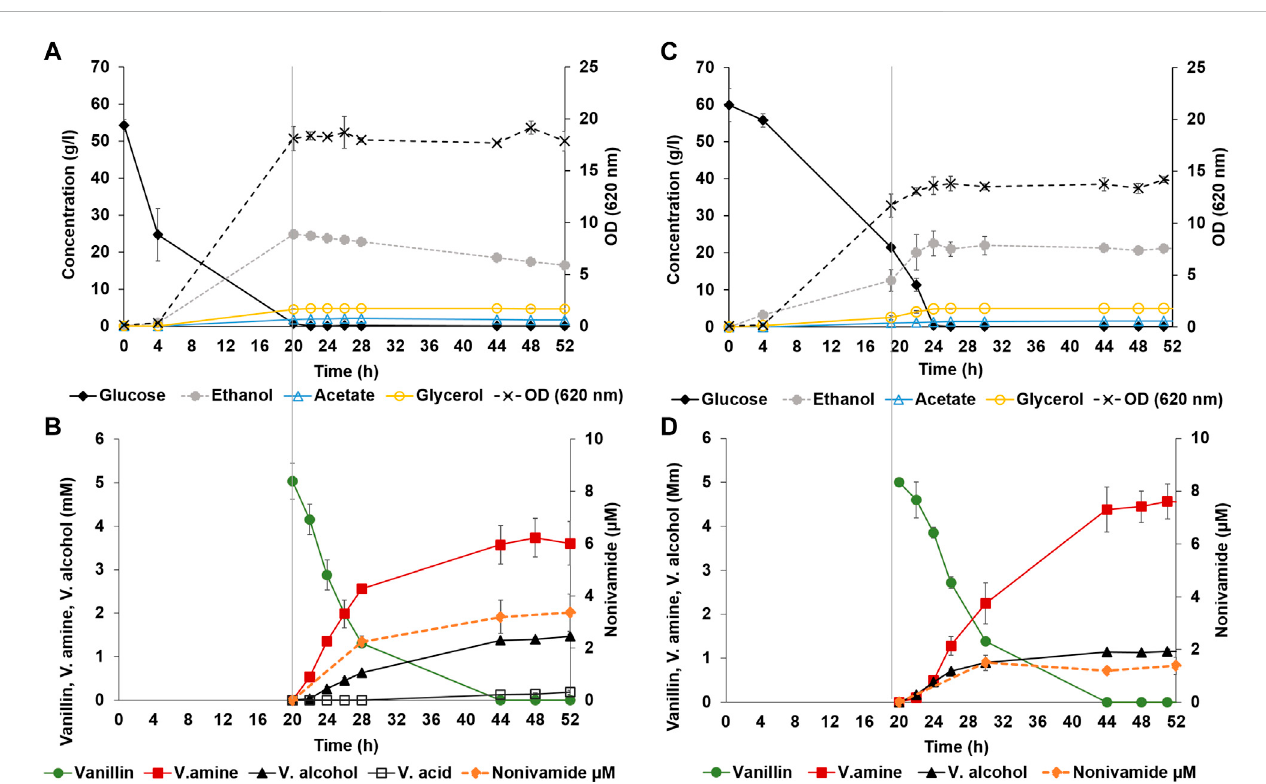
FIGURE 3 Bioreactorcontrolledwhole-cellbioconversionofvanillinandnon-anoicacidtononivamidebyyeaststrainTMBNM034,co-expressingCvTA,BsAlaDH, CaAT/IpfF and with deleted ADH6. During the fi rst 20 h both bioreactor set-ups were treated in the same way, after which (marked with vertical line) vanillin andnon-anoicacidwereaddedandaerationwaskeptat0.5 vvm (A,B) orstopped (C,D) .Leftaxispresentsmeasuredfermentationmetabolitesglucose(black diamond), ethanol (dotted line with grey circle), acetate (empty blue triangle), glycerol (empty yellow circle) shown in g L − 1 (A, C) ; and bioconversion metabolites vanillin (green circle), vanillylamine (red square), vanillic alcohol (black triangle), vanillic acid (black empty square) shown in mM (B, D) . Right axes present OD 620nm [dotted line with black cross; (A, C) ] or nonivamide in µM [orange dotted line with circle; (B, D)